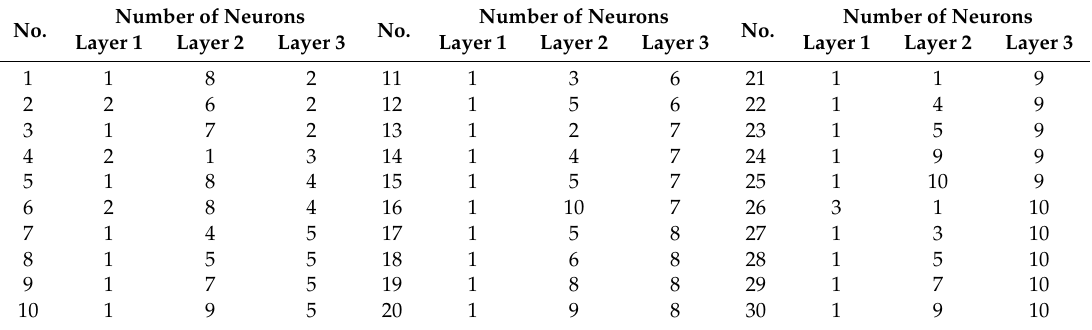
Table 8. Network topologies of the failed models in the hyperbolic tangent artificial neural network (ANN)